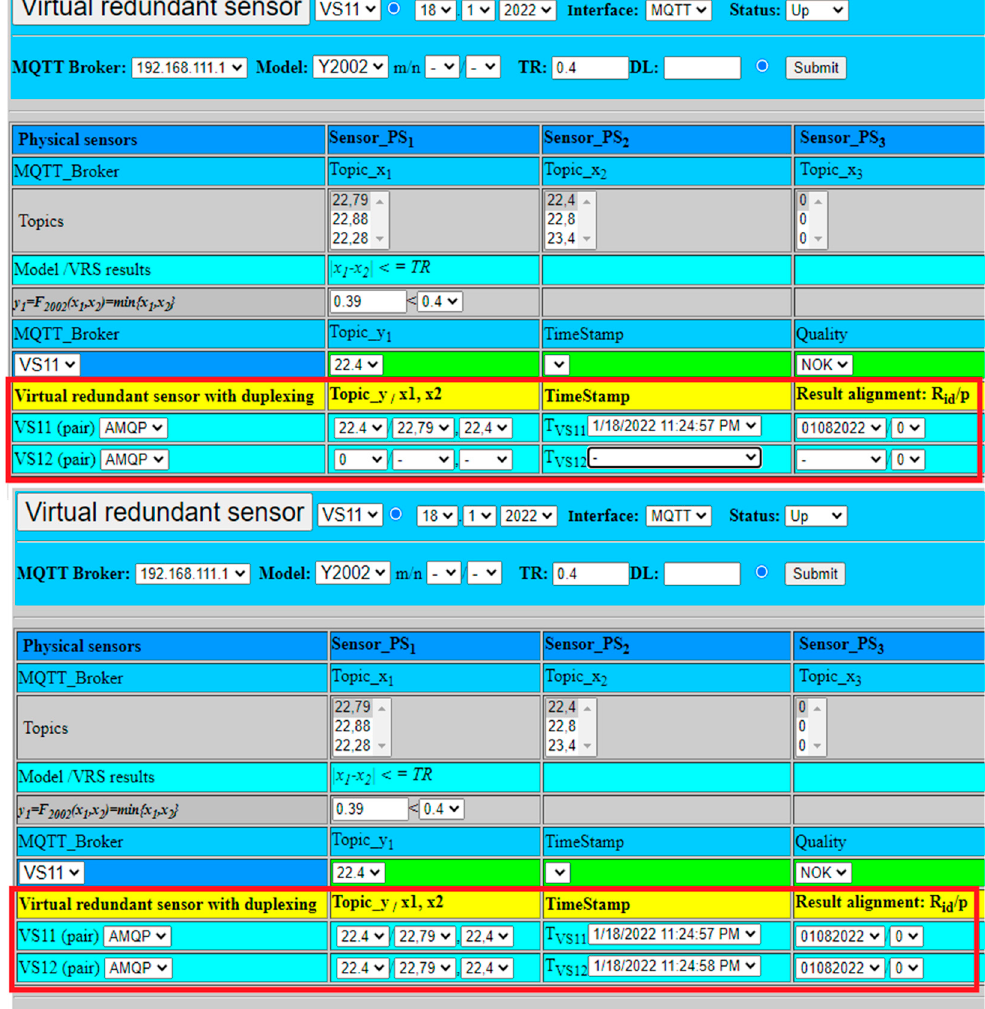
Figure 17. Virtual redundant sensor VS11 with duplexing with example of result confirmation.